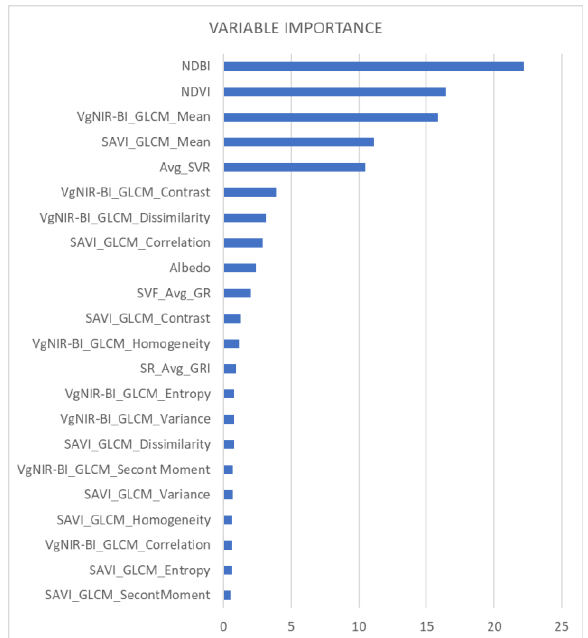
Figure 8. Random forest-derived variable importance